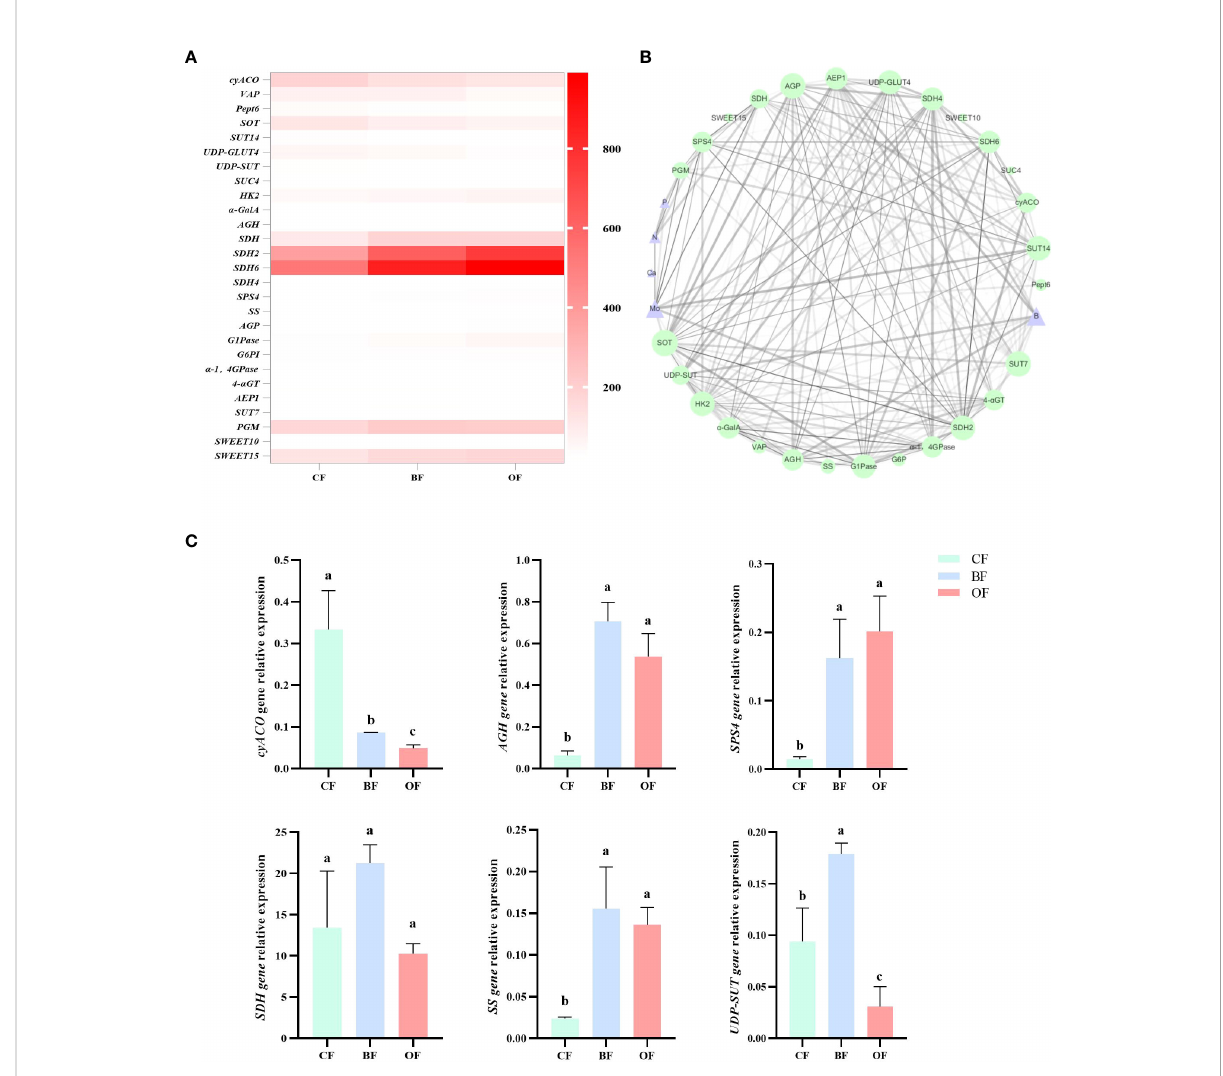
FIGURE 6 (A) Heatmap of candidate hub genes for regulation of sugar and organic acid metabolism in the MEBlue, MEturquoise and ME fl oralwhite modules. CF: chemical fertilizers application; BF: chemical fertilizers + bio-organic fertilizers application; OF: chemical fertilizers + organic fertilizers application. The FPKM values of CF, BF and OF from white (5) to red (1000). (B) Construction of regulatory networks of sugar and organic acid metabolism gene (green) in the MEBlue, MEturquoise and ME fl oralwhite module, which positively correlated with nutrient contents (purple) (r 2 >0.7). Hub genes (key candidates) within each network are highlighted in size due to the highest weight within the module and coded for gene descriptors based on annotations, the strength of correlation between hub genes by weights of lines. (C) Quantitative RT-PCR data